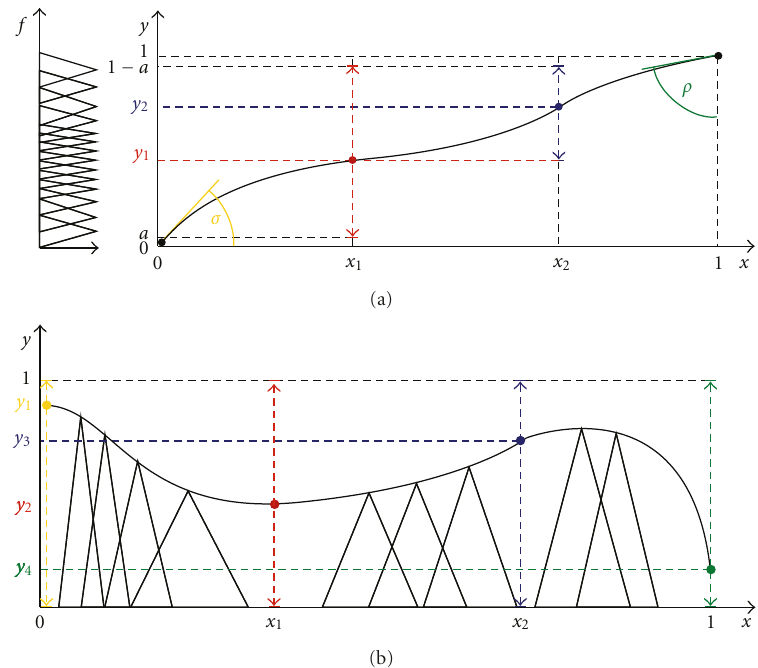
Figure 3: Schemes illustrating the use of splines to optimize the filterbanks. (a) A spline being optimized to determine the frequency position of filters, and (b) a spline being optimized to determine the amplitude of the filters.